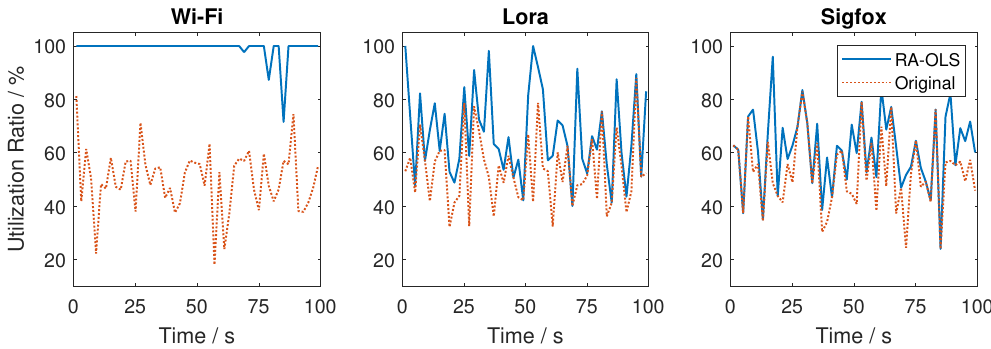
Figure 9. Utilization rate among individual links with K = 2 UAVs. (The blue solid lines are the link utilizations with RA-OLS, while the orange virtual lines represent the initial link occupation without